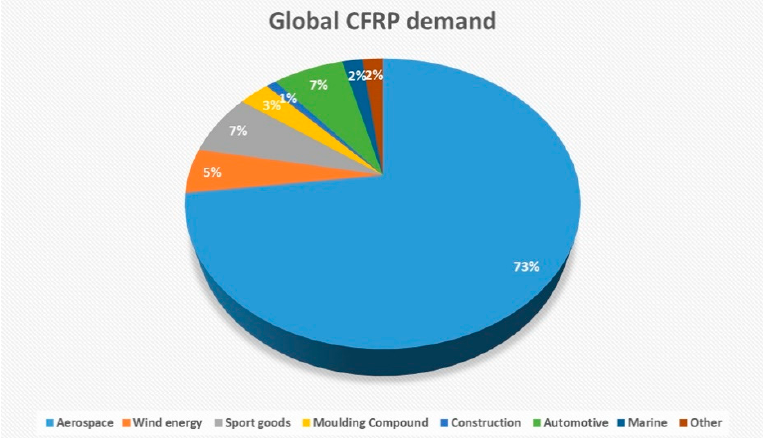
Figure 1. Global demand based on sales (2018) [20] . CFRP, carbon fibre reinforced polymer.